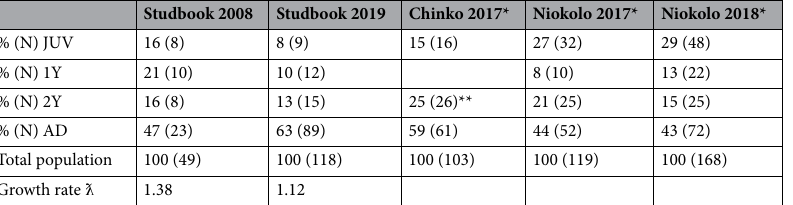
Table 3. Comparison of the Derby eland population structure, showing the ratio of juvenile (JUV), 1-year (1Y) and 2-year (2Y) olds, and adult (AD, ˃ 2 years old) individuals in the fenced reserves in Senegal, as calculated from Studbook 2008 (Antonínová et al. 33 ) and Studbook 2019 (Brandlová et al. 52 ). The number of recorded detections in the Chinko Protected Area, Central African Republic (Brandlová et al. 13 ), and the current datasets are reported, and referred to as ‘Niokolo 2017’ and ‘Niokolo 2018’. The growth rates were calculated for the population in the fenced reserves, and show high values, even if a much lower number of JUV and SUB individuals are reported than for that of the wild populations. *Numbers of animals detected using the camera traps serve only as indexes of population size. **The number contains the sum of 1Y and 2Y